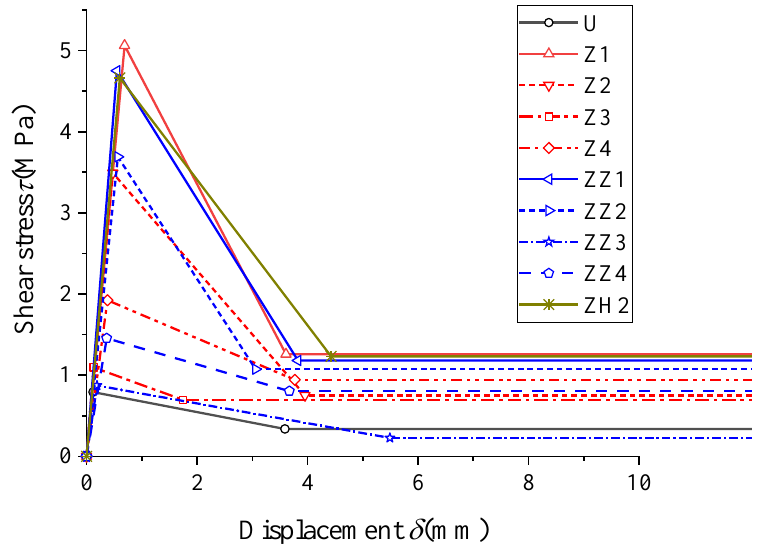
Figure 19. Calibrated tri-linear bond-slip models for all pullout tests (all curves are flat for 10 mm ≤ δ ≤ 40 mm).